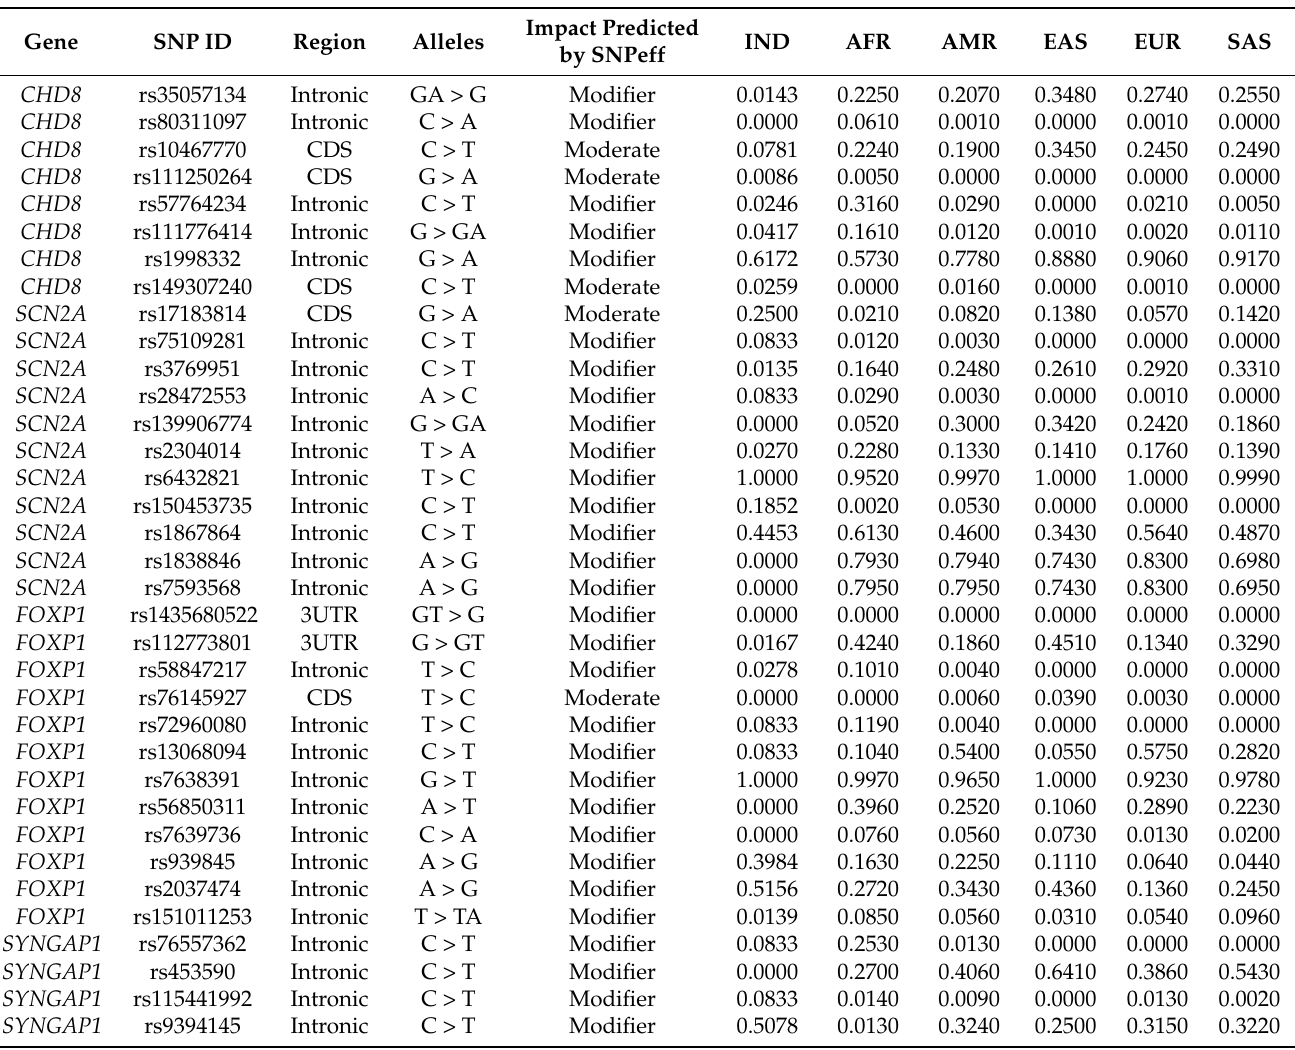
Table 1. Description of variants in the CHD8 , SCN2A , FOXP1 , and SYNGAP1 genes in the Indige- nous group and continental populations (African, American, East Asia, European, and South Asia) described in the 1000 Genomes